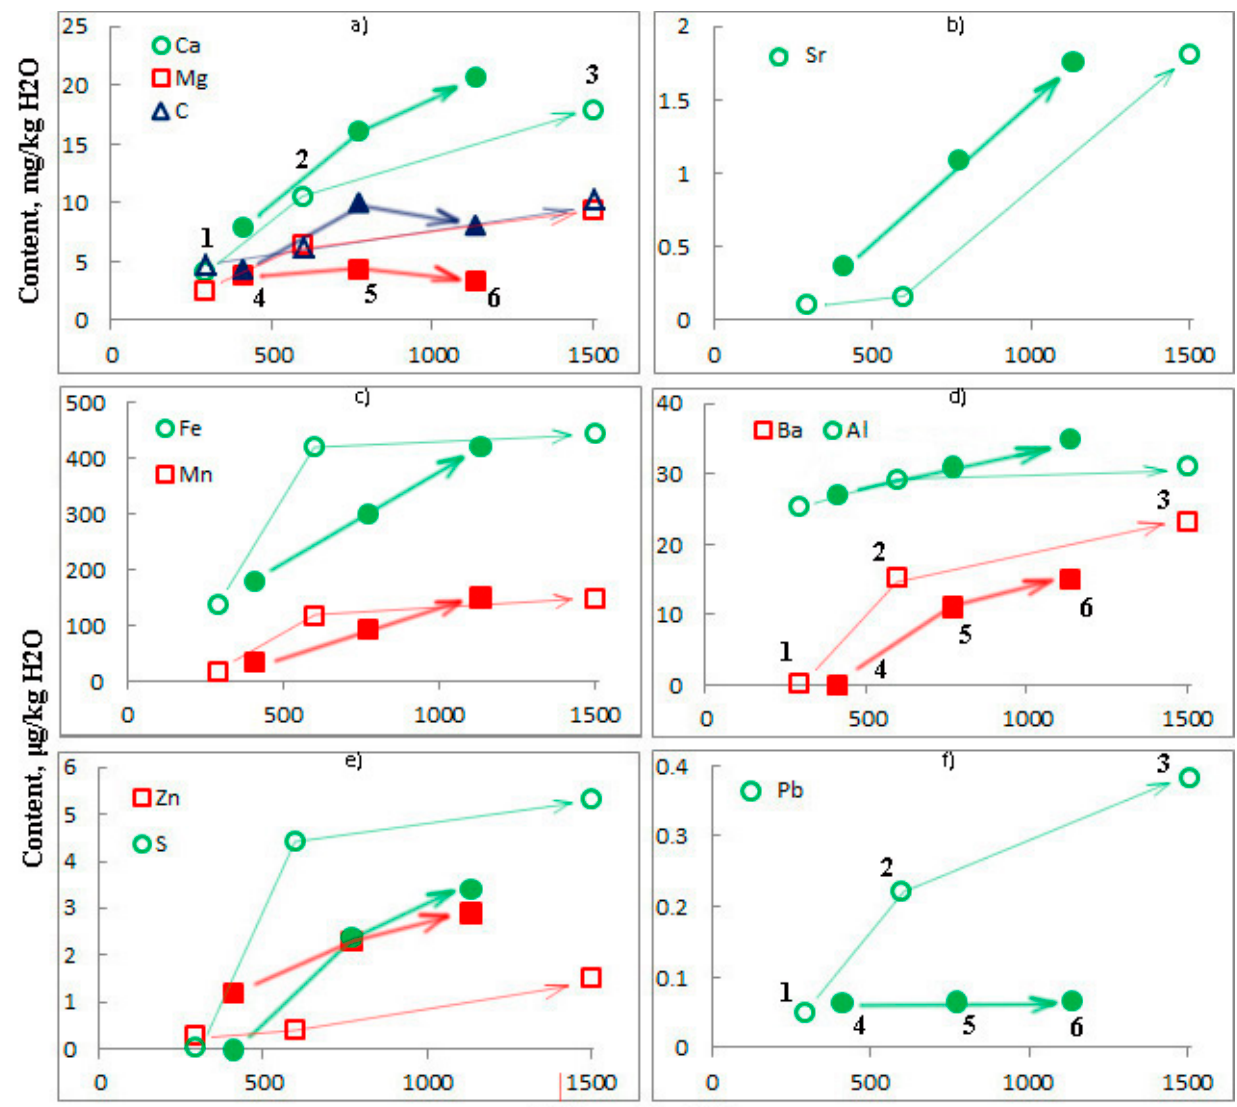
Figure 8. Dependence of changes in concentrations of precipitated major and trace elements from obtained solutions: ( a ) Ca, Mg and C; ( b ) Sr; ( c ) Fe and Mn; ( d ) Ba and Al; ( e ) Zn and S; ( f ) Pb according to Scenarios 1–3 (without filling marker) and 4–6 (complete filling of marker) from TDS of these solutions (see Tables 2 and 3).